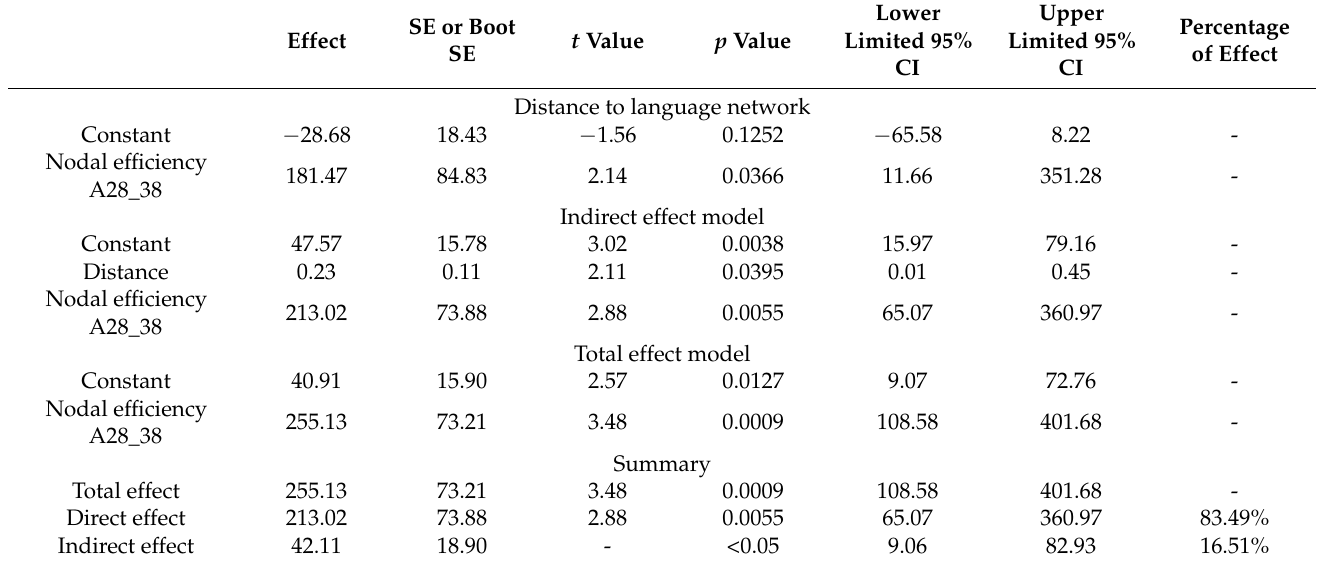
Table 4. Testing the mediation effect of nodal efficiency of A28_34 in the healthy hemisphere on language performance.